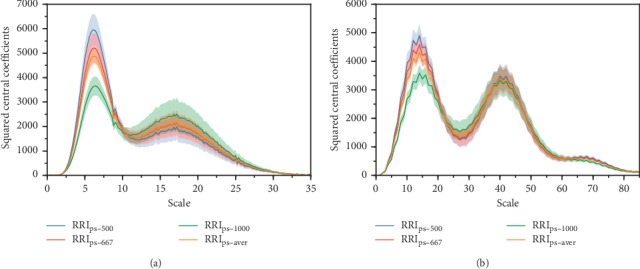
Squared central wavelet coefficients of PRSA curves obtained after interpolation and resampling at different scales. The shaded area represents the variation range of each curve. (a) Wavelet analysis using the third-order Gaussian wavelet. The maximum coefficients occur at scale s = 6.2. (b) Wavelet analysis using the Haar wavelet. The maximum coefficients occur at scale s = 14.0.